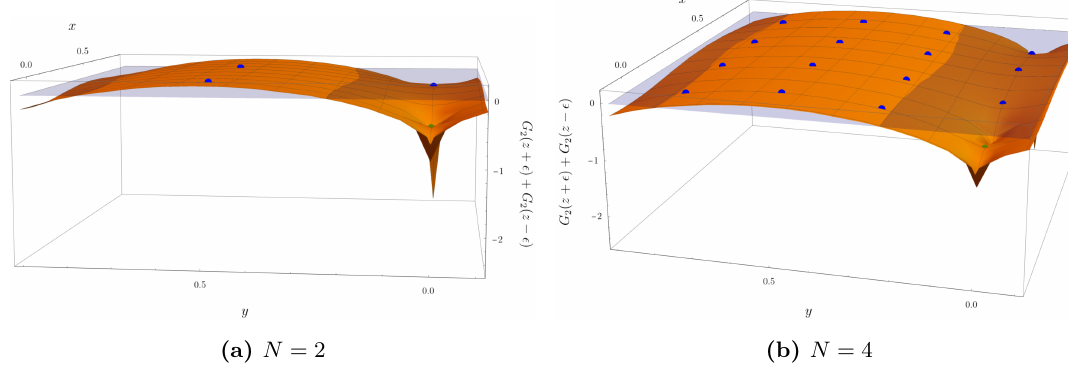
Figure 1. Plot of G tot . for τ = 2 i and (cid:15) = 0 . 1 . The blue dots are the ED3 open string landscape points, and the green one z = 0 .